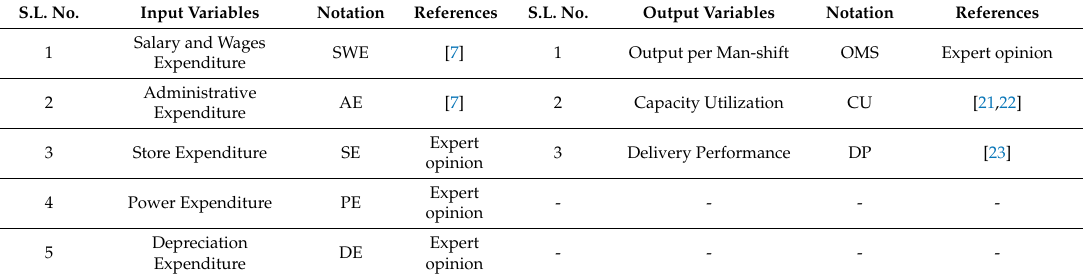
Table 1. The input–output variables, their notation, and